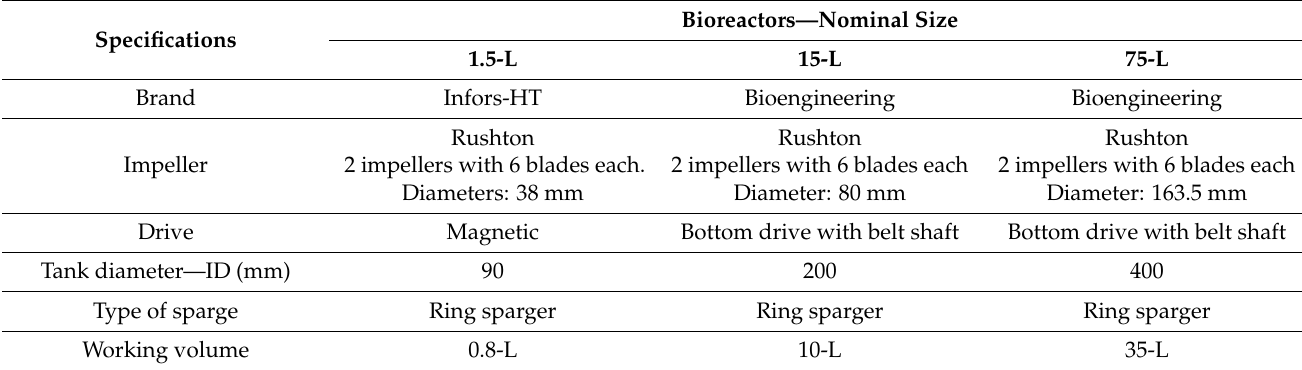
Table 1. Comparison of bioreactor systems’